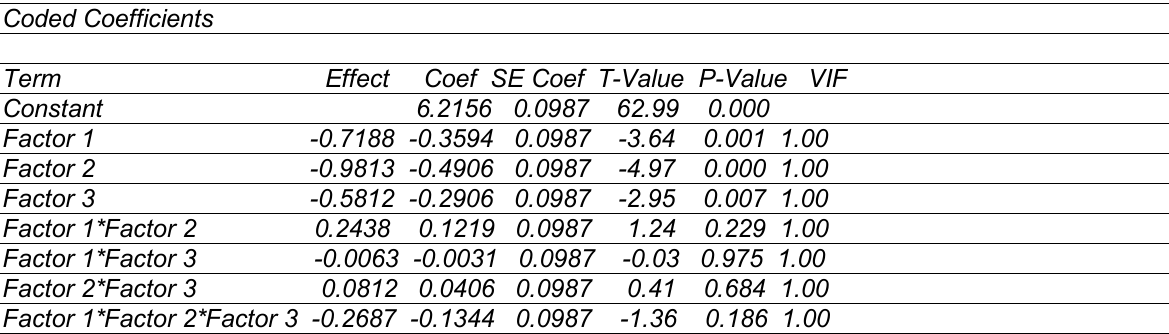
Table 6: Effect Levels of